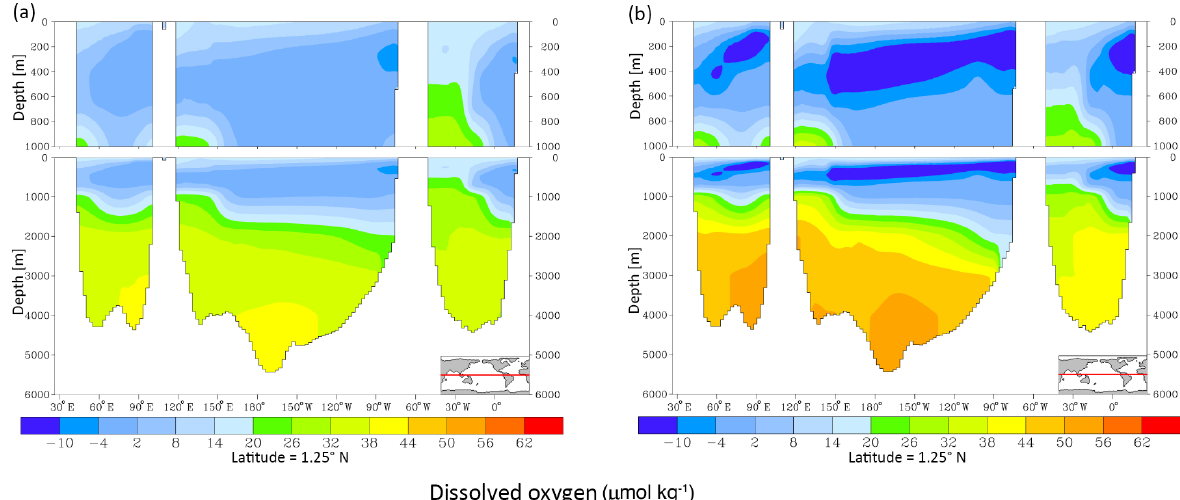
Figure 9. The difference in the dissolved oxygen concentration between (a) the 25% reduction in ventilation and the 4 × CO 2 simulation with radiative forcing and (b) the 50% reduction in ventilation and the 4 × CO 2 simulation with radiative forcing.